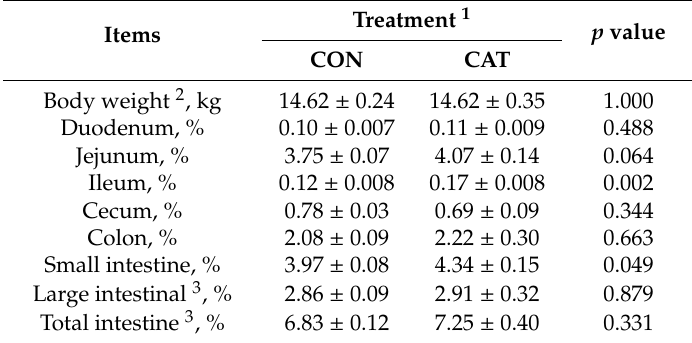
Table 1. E ff ect of dietary exogenous catalase supplementation on the intestinal relative weight of weaned